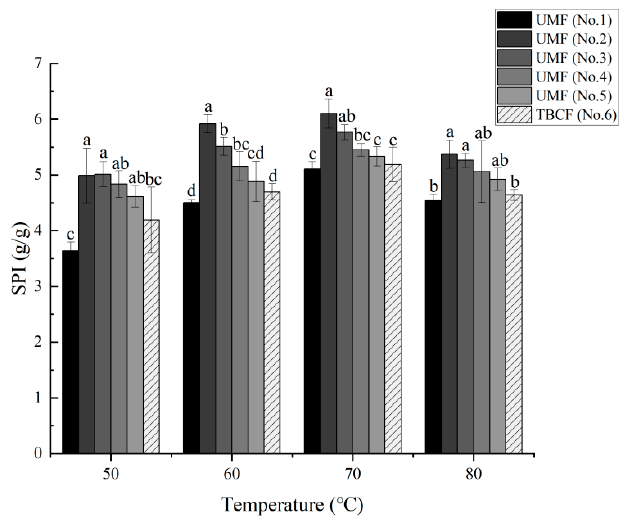
Figure 4. Effects of airflow ultrafine-grinding on the swelling power in Tartary buckwheat flour. The values represented by the different letters are significantly different at p < 0.05 compared with each other among the same temperature.